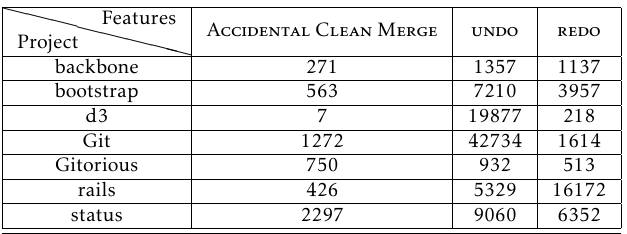
Table 2. ACM and Undo/Redo in git